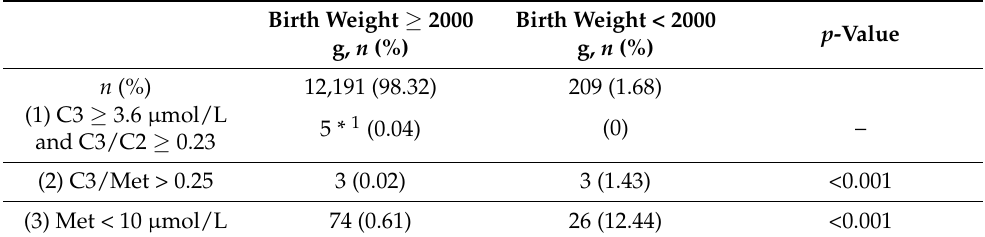
Table 5. Correlation between low birth weight and